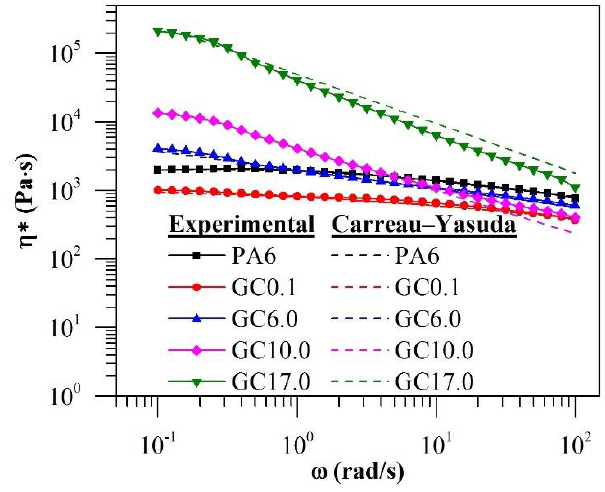
Figure 6. The η * of PA6 and GC with a change in ω at 245 ◦ C. Figure 6. The η* of PA6 and GC with a change in ω at 245 °C.